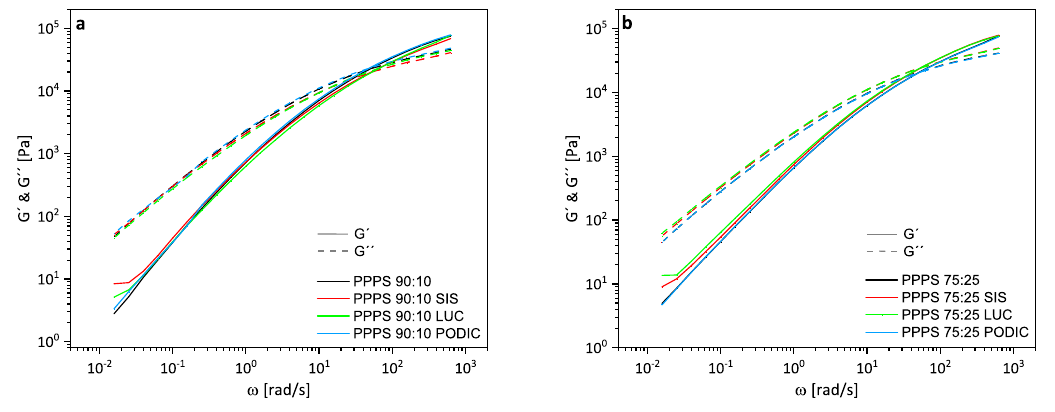
Figure 4. Storage and loss modulus (dashed) curves of PP–PS 90:10 ( a ) and PP–PS 75:25 ( b ) blends; measured at 230 ◦